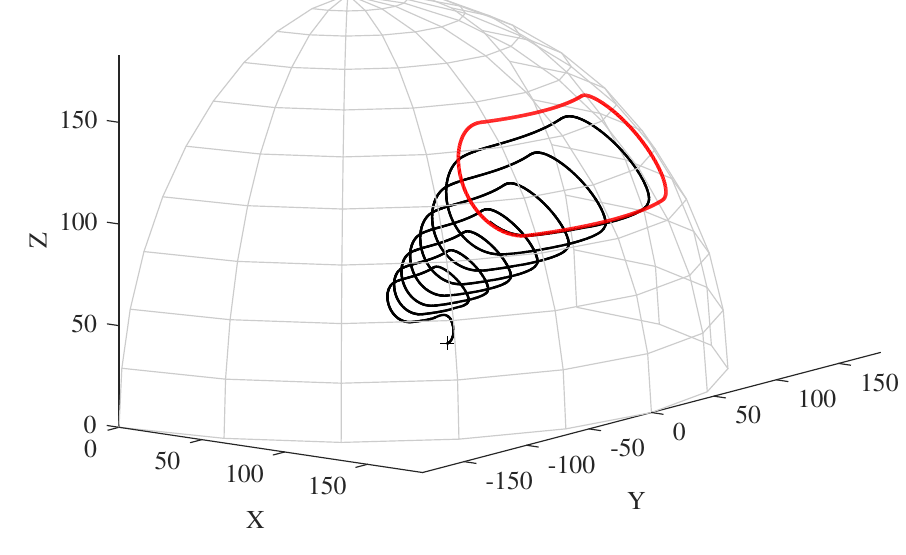
Figure 7. 3D kite trajectory.